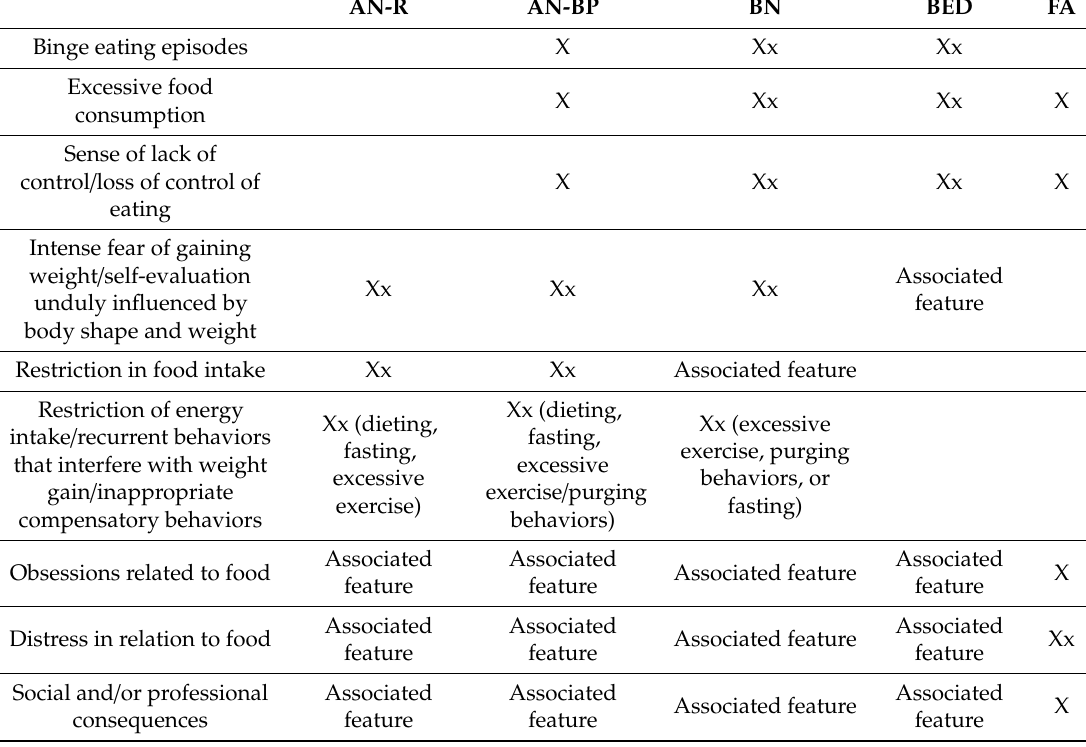
Table 1. Discrepancies and similarities between food addiction (FA) and all types of eating disorders (Eds): comparison of di ff erent criteria between each of the types of disorders. AN-R AN-BP BN